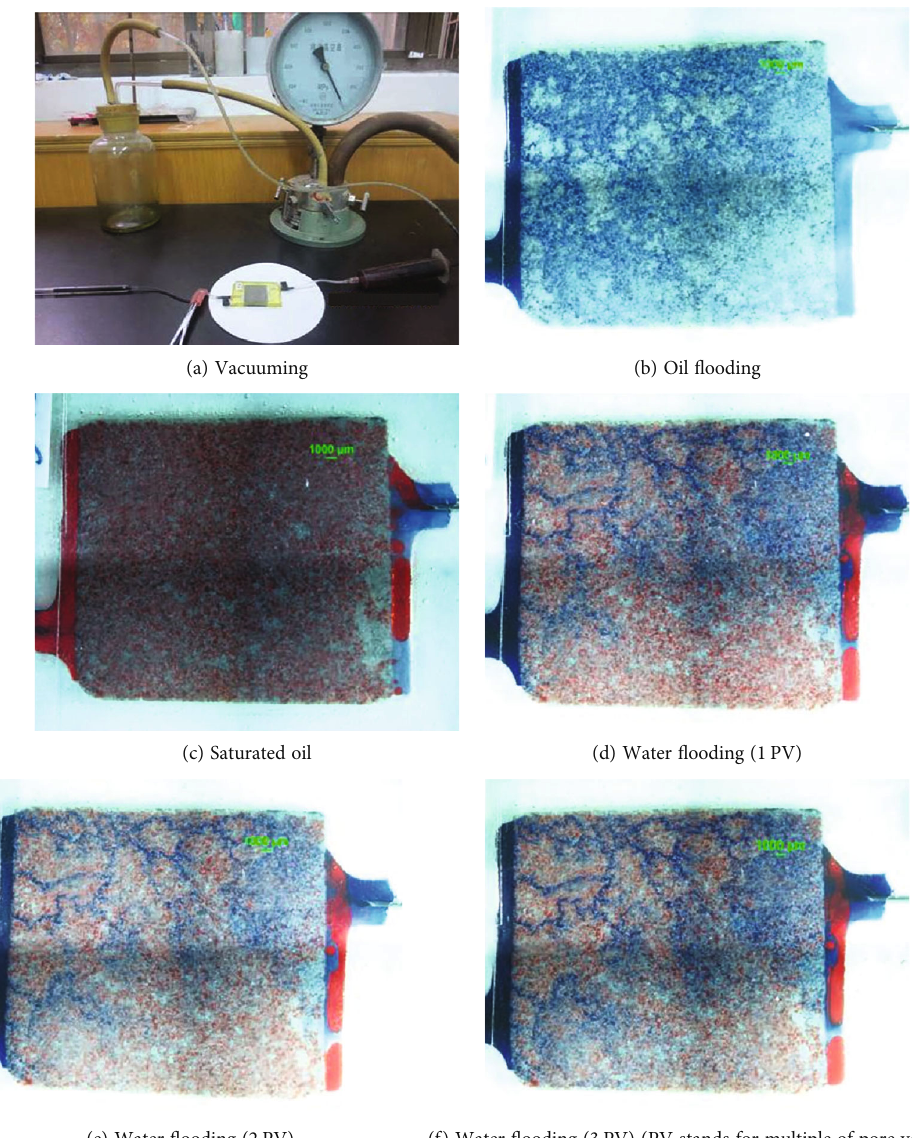
Figure 3: The image of real microcosmic water fl